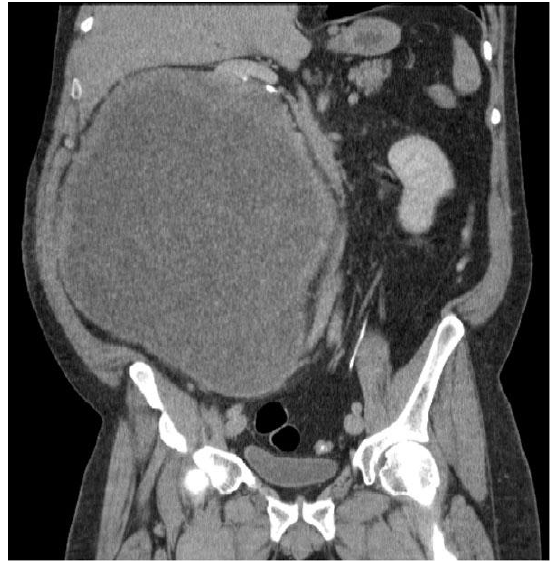
FIGURE 2. Coronal CT scan image of large right renal mass showing displacement of other abdominal